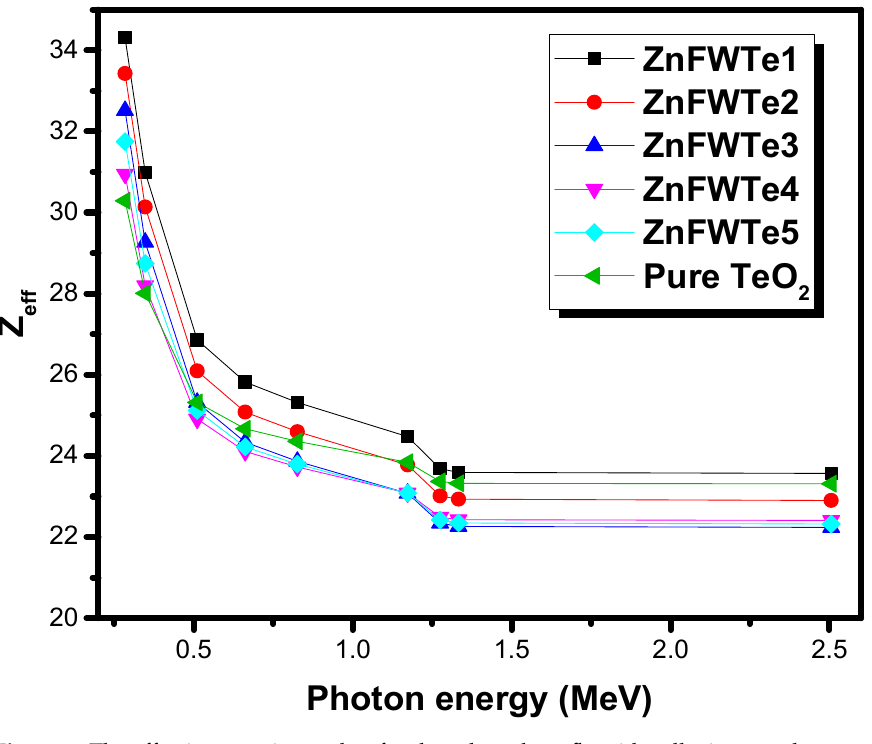
Figure 3. The effective atomic number for the selected oxyfluoride tellurite samples.